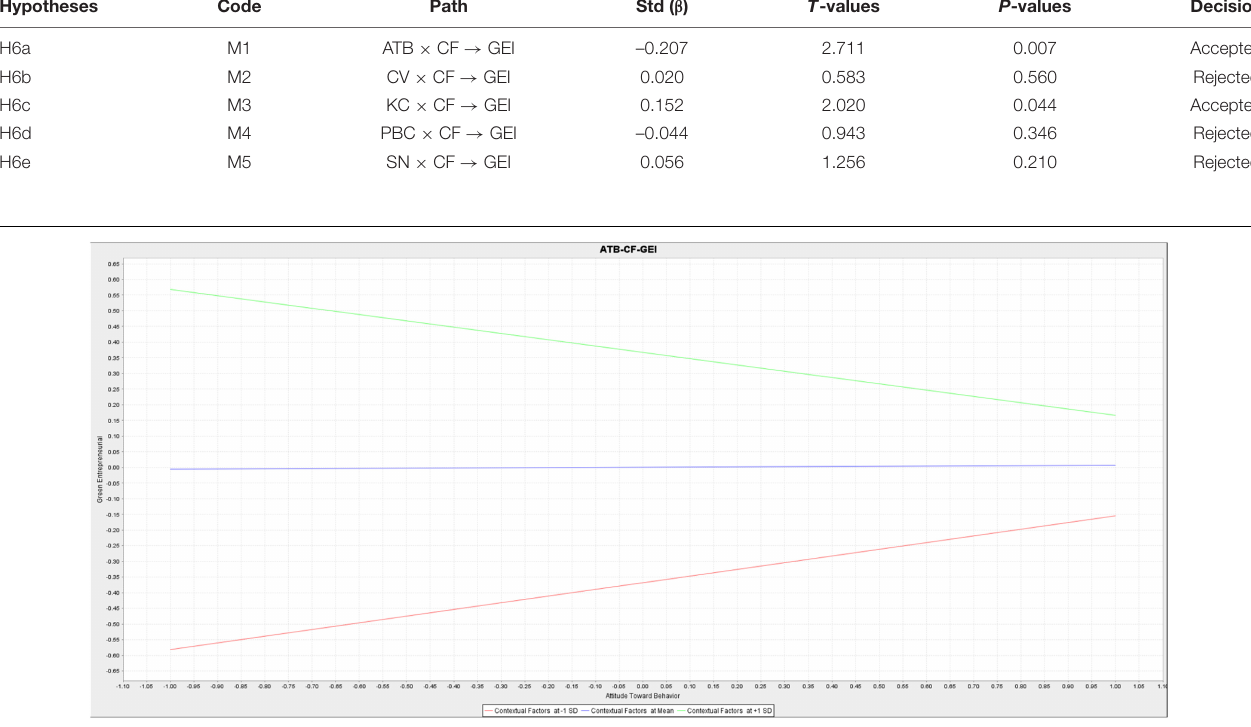
Frontiers in Psychology |